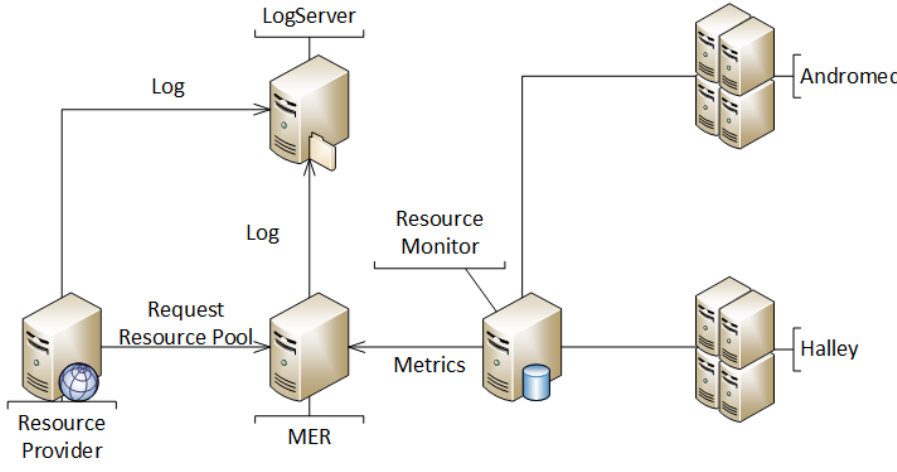
Figure 2. Conceptual model of